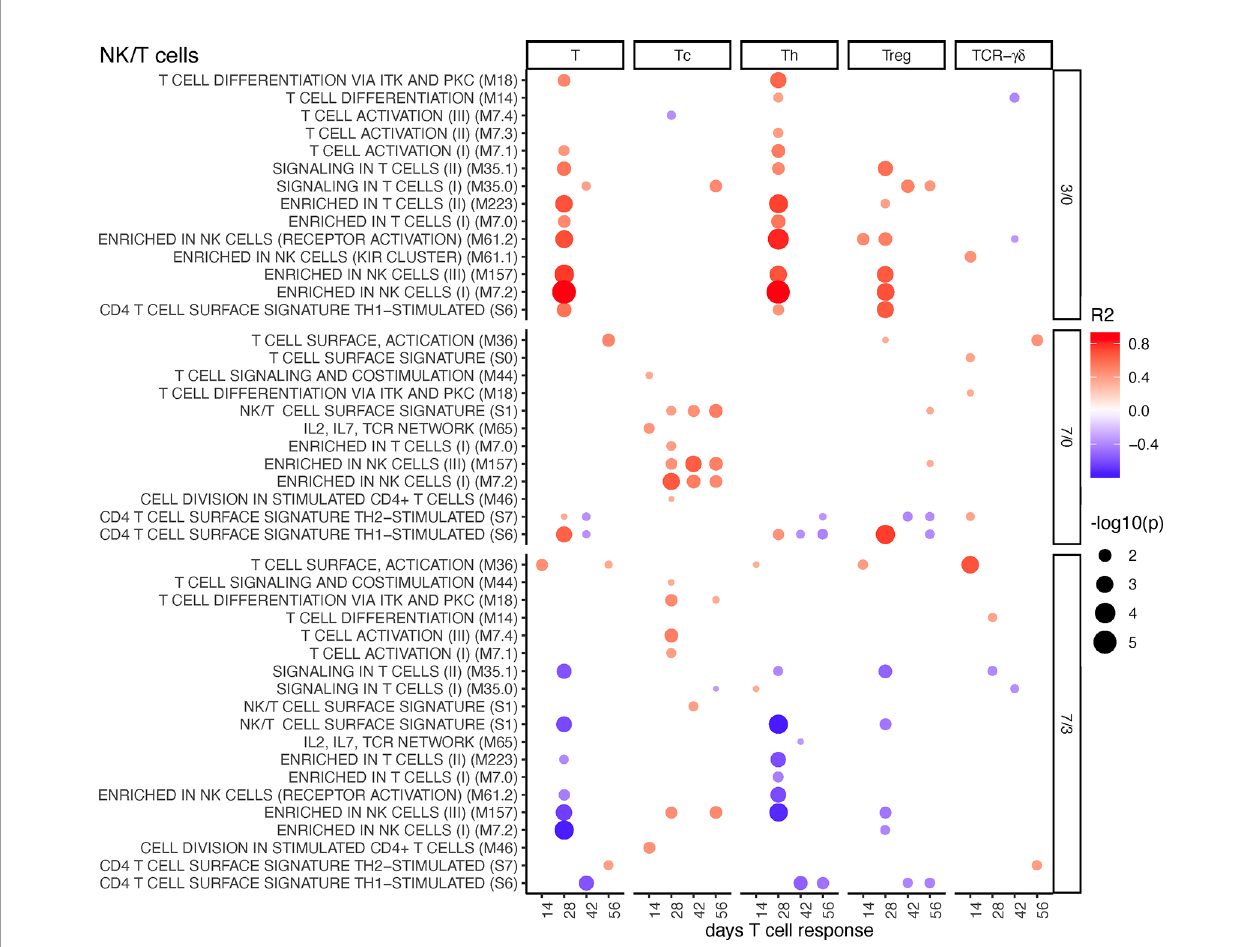
FIGURE 6 | T/NK cell BTM correlating with T-cell priming. Time-dependent single-sample enrichment scores for BTM were correlated with the proliferative recall response of total CD3 + T cells, Tc, Th, and TCR- gd T-cells measured at 14, 28, 42, and 56 days after LP or HP PRRSV-2 infection [x-axis, data from (15)]. R squared correlation coef fi cients for the BTM changes from D3/0, D7/0, and D7/3 are indicated by the color gradient (red for positive values, blue for negative values). Increased circle sizes indicate smaller p values (cutoff <